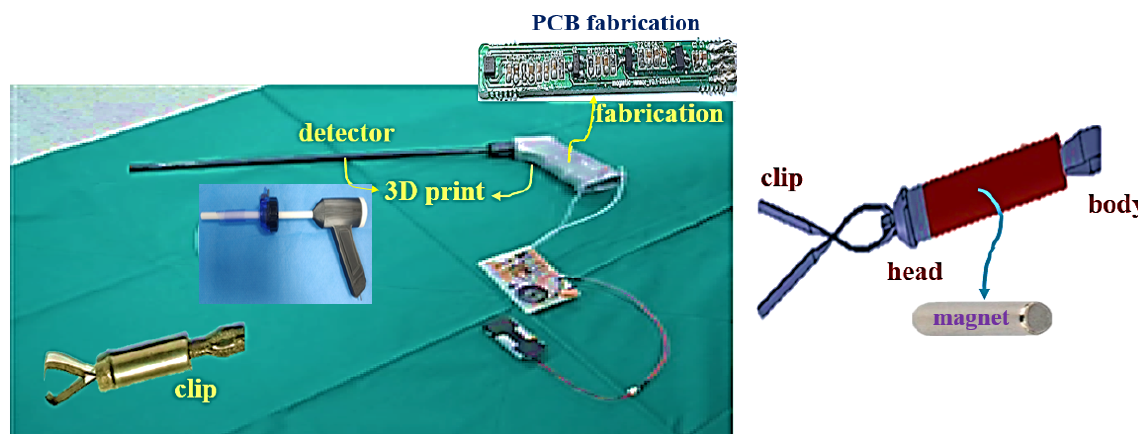
Figure 7. Fabrication of the clip and detector.